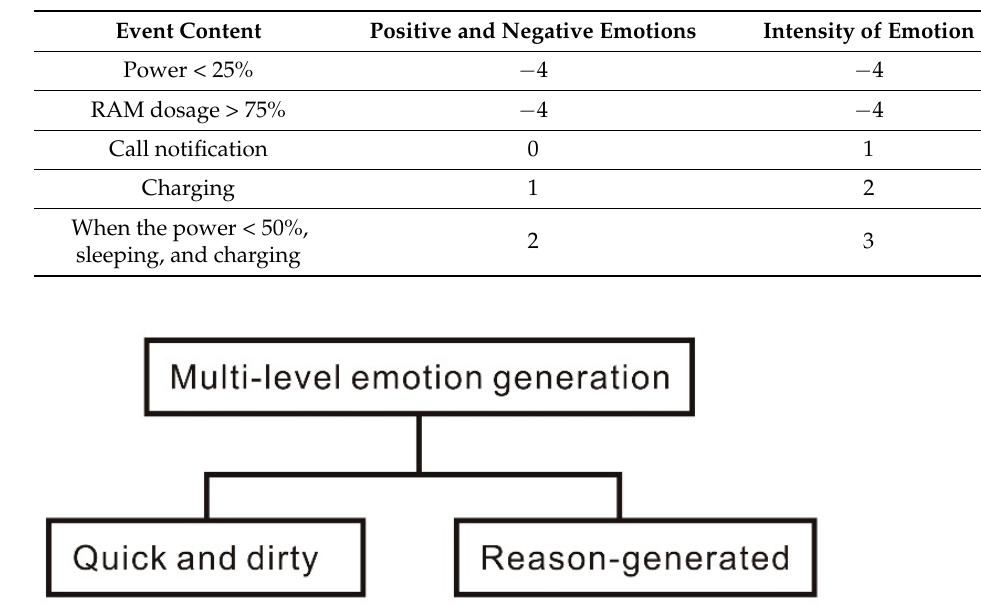
Figure 6. Schematic of multidimensional emotion generation.